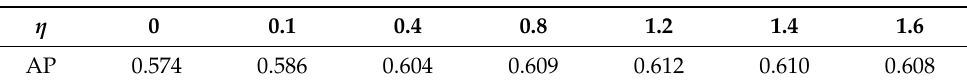
Table 4. The AP values of the results were obtained by comparing different η values on the UCAS- AOD dataset. (AP is the average of 10 values of AP taken between IoU = 50 and IoU = 95). η 0 0.1